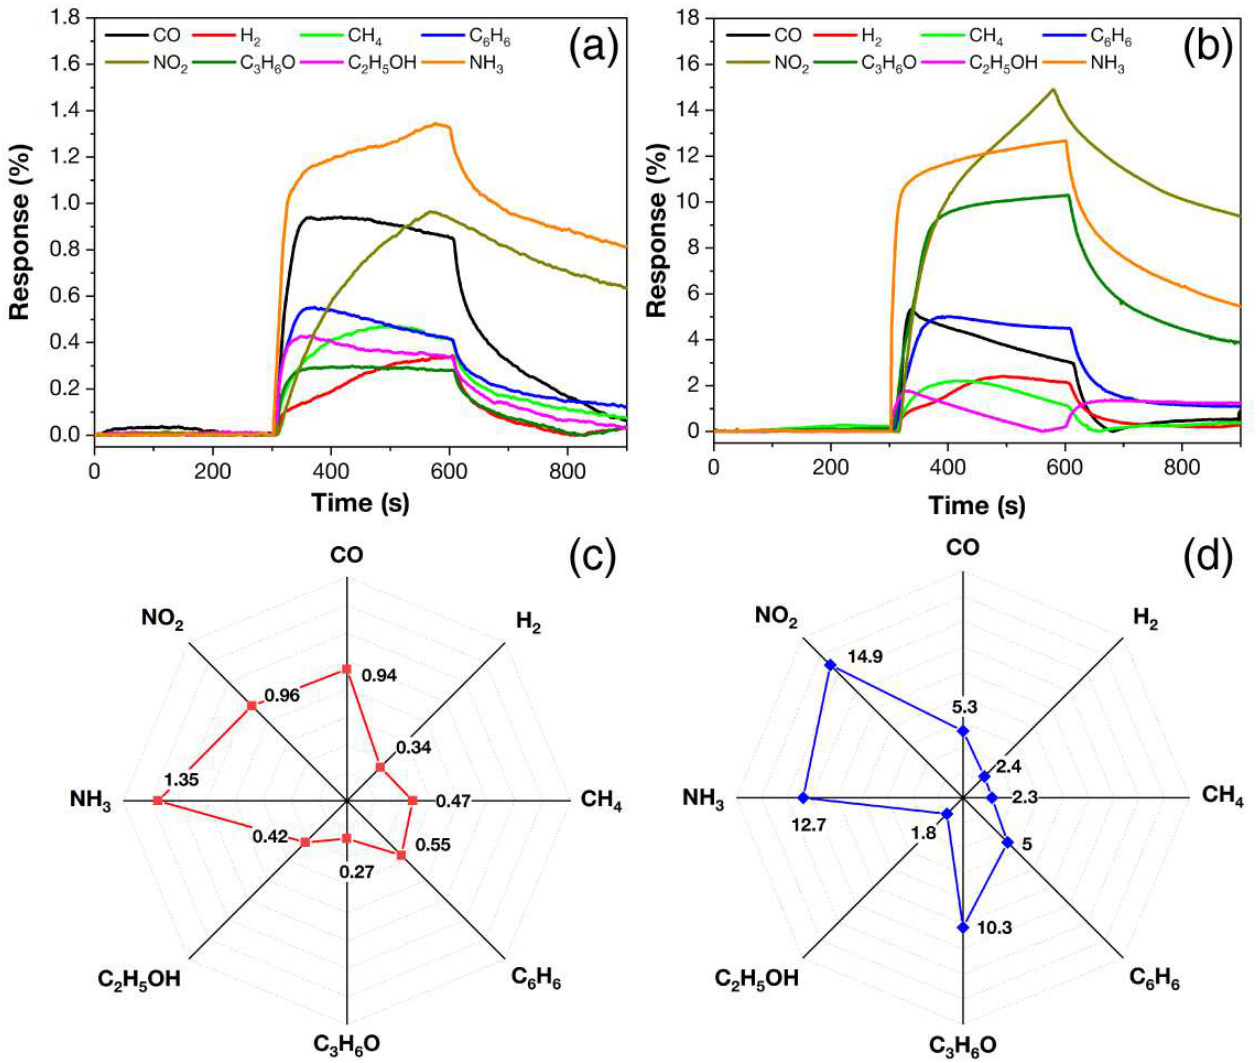
Figure 6. Responses (%) to various gases (100 ppm CO, NH 3 , NO 2 , C 6 H 6 , C 3 H 6 O, C 2 H 5 OH and 1000 ppm CH 4 , H 2 ) and V 2 CT x MXene film selectivity diagrams before ( a , c ) and after oxidation ( b , d ); all data obtained at RT and 0%RH.